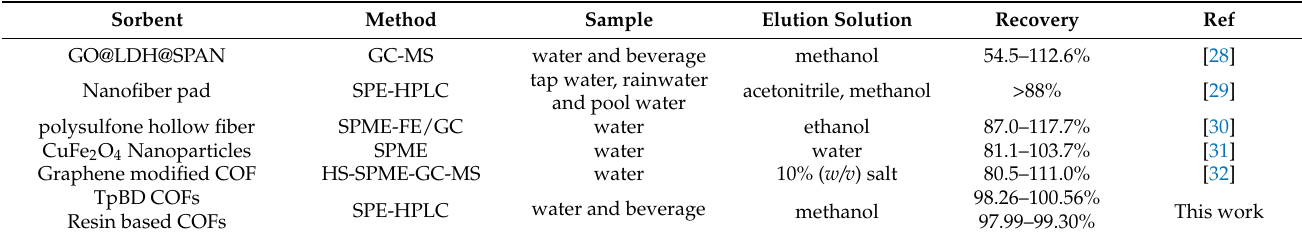
Table 5. Comparison with the reported PAEs determination method